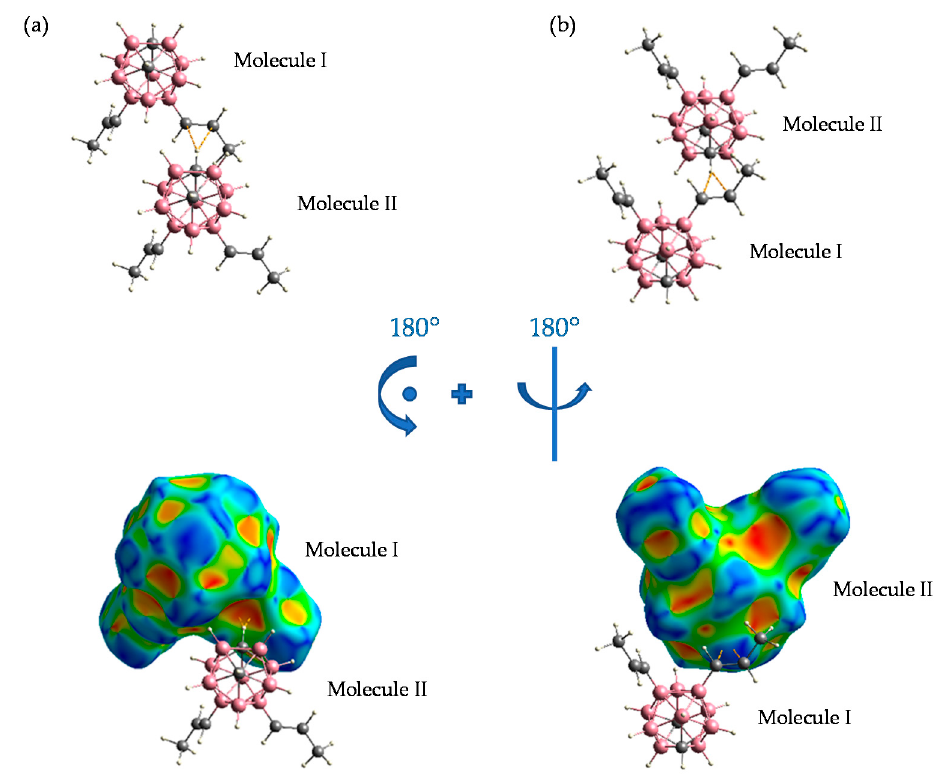
Figure 9. Shape index presentation of 12 showing the red concave and the blue convex areas, which correspond to ( a ) H … π and (b) π … H, respectively.